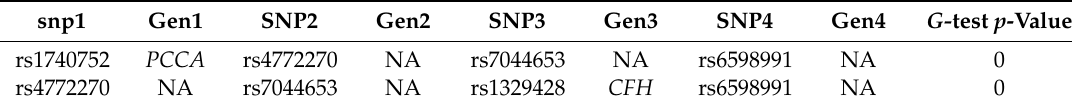
Table 5. 4-way SNP combinations identified using a G